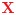
Primer-extension assay.Elongation complexes consisted of an unlabeled template DNA strand (bottom sequence) and a 5’-labeled RNA primer (top sequence). The X represents the last nucleotide in the RNA primer (the n-1 position), IE* represents the incorporation efficiency (normalized to a value of 100% for the natural rNTP reactions), and P represents non-elongated RNA primer. (A) The primer-extension assay conducted in the presence of the 5’NH CTP or natural CTP. (B) The primer-extension assay was conducted in the presence of 5’NH GTP or natural GTP. (C) The primer-extension assay was conducted in the presence of 5’NH UTP or natural UTP. The gels are a representative of three replicate experiments.